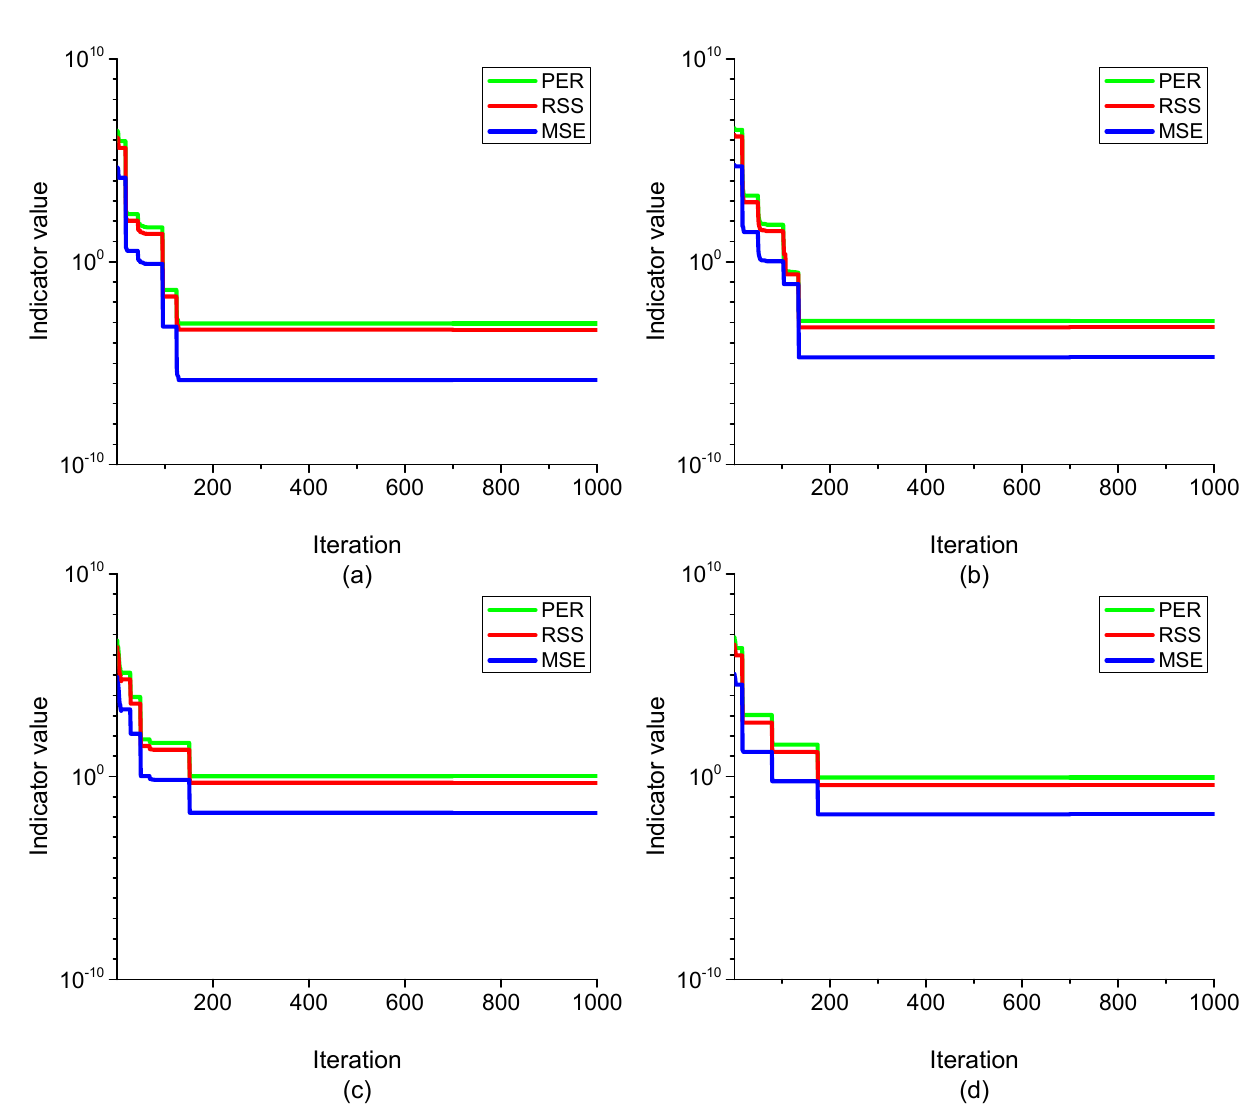
Figure 7. The convergence characteristics of the GWO-LS framework for the case study I ( a ) non-noisy signal ( b ) 40 dB ( c ) 20 dB and ( d ) 10 dB. Table 6. GWO-LS Numerical Comparison for Case Study II.